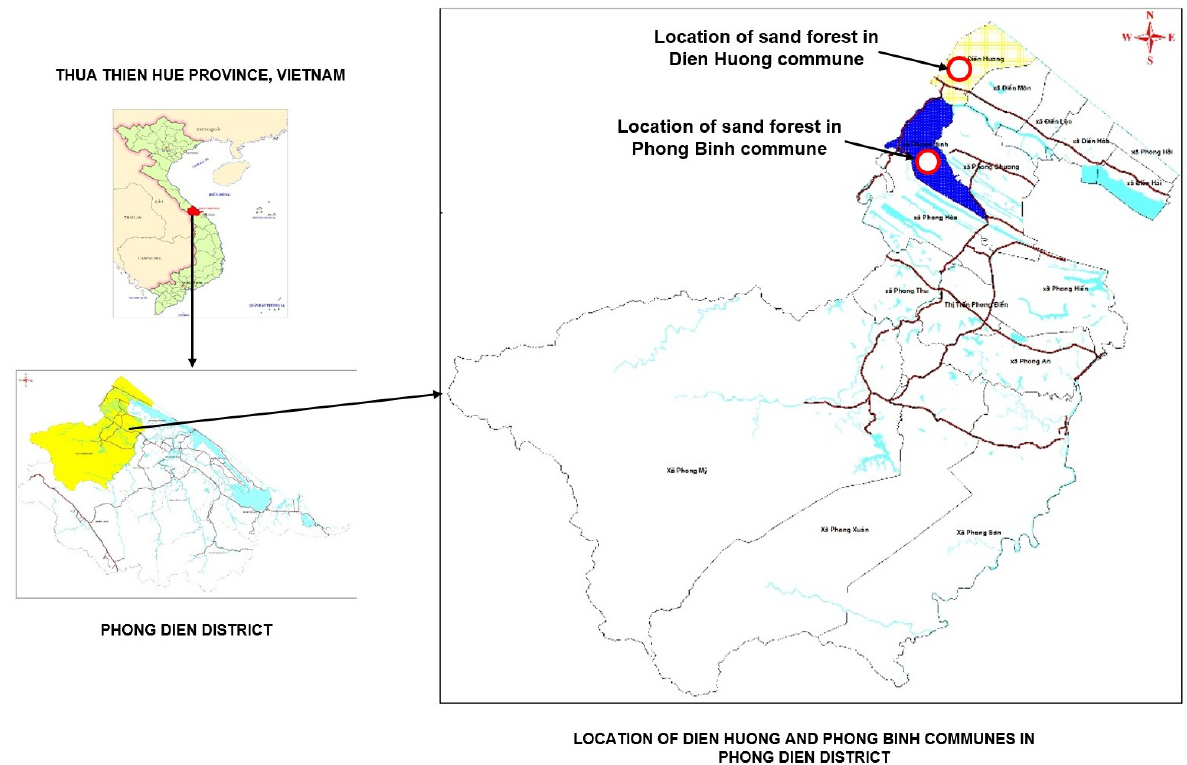
Figure 1. Location of the study area.